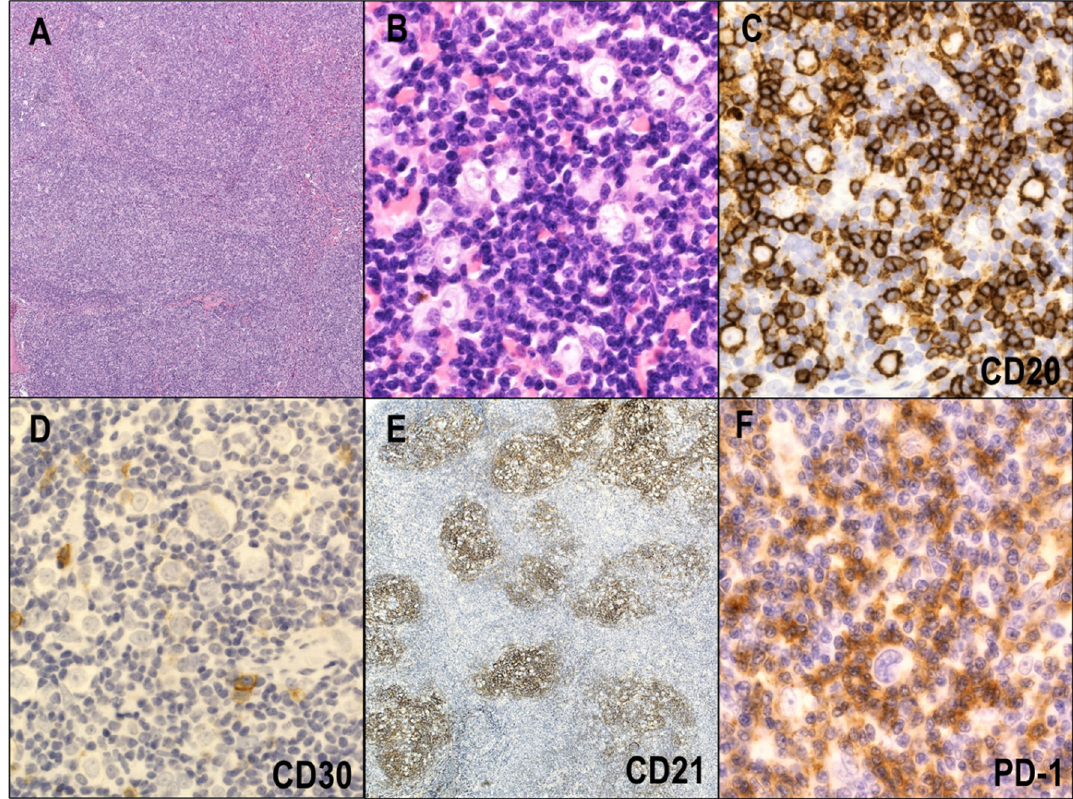
Figure 6. Nodular lymphocyte predominant Hodgkin lymphoma (NLPHL). ( A ) A majority of NLPHL cases are characterized by a nodular growth pattern (HE × 40). ( B ) The nodules consist of abundant small reactive B lymphocytes, epithelioid histiocytes, and intermingled neoplastic cells called lymphocyte-predominant (LP) cells (HE × 400). ( C ) LP cells express CD20 (×400). ( D ) CD30 is rarely expressed in LP cells (×400). ( E ) Immunostaining for CD21 highlights the FDC meshwork within nodules (×40). ( F ) LP cells are characterized by rosetting of PD1-positive T cells (×400).